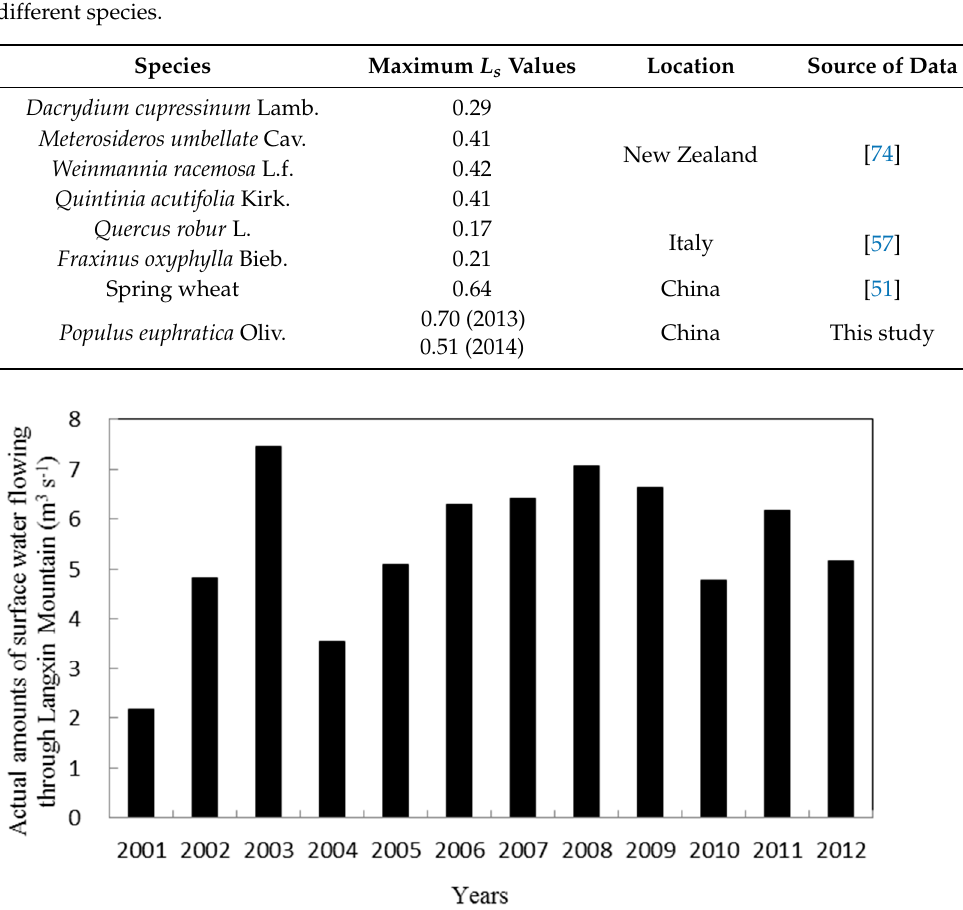
Table 4. Maximum values of stomatal limitation of photosynthesis ( L s ) under natural conditions for different species.